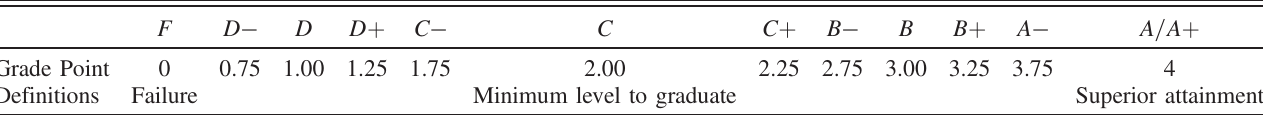
TABLE II. Letter grades and corresponding grade points.